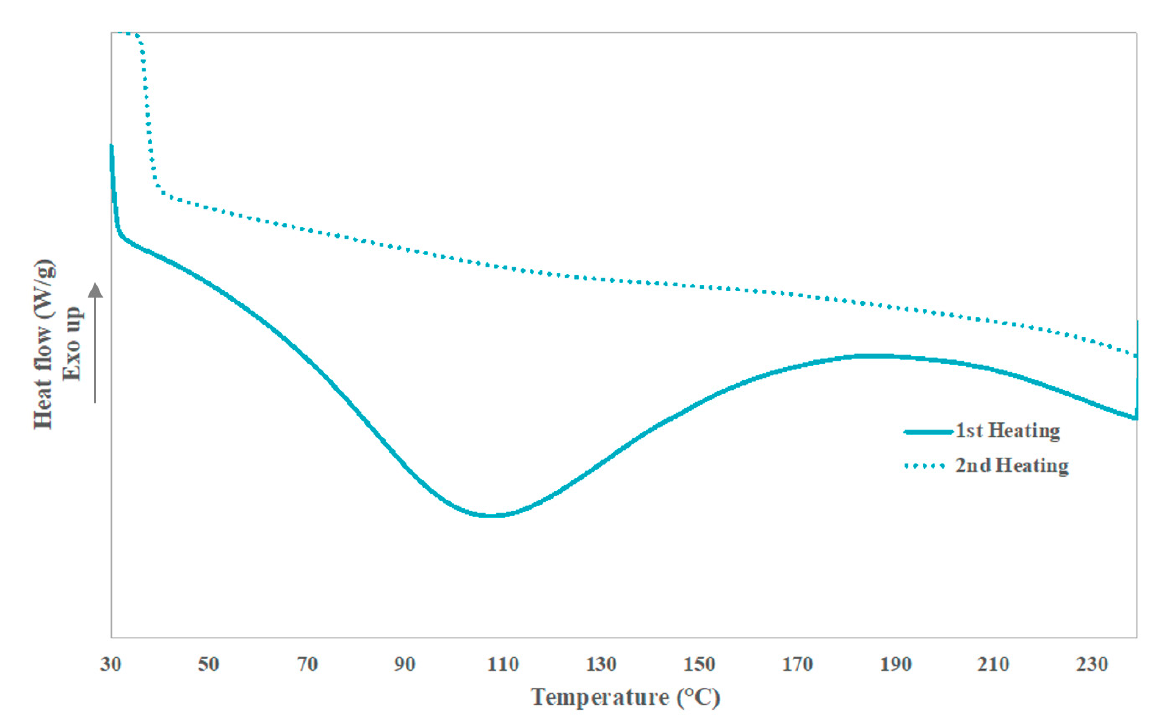
Figure 3. DSC thermograph of buffing dust waste.